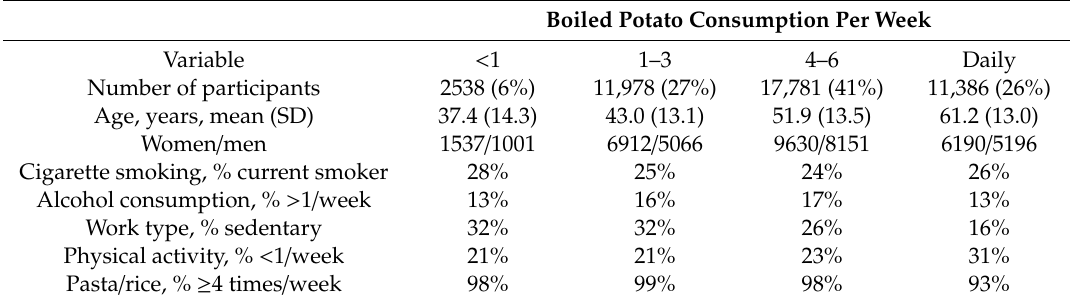
Table 1. Selected characteristics according to boiled potato